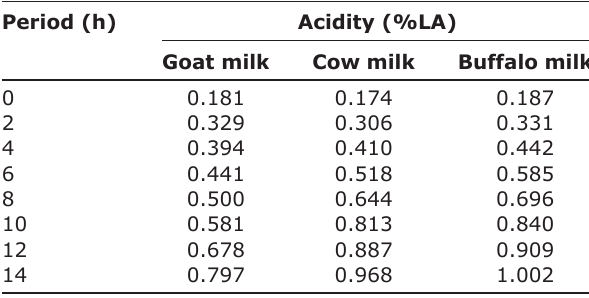
Table-3: Rate of acid production by starter culture of goat, cow and buffalo